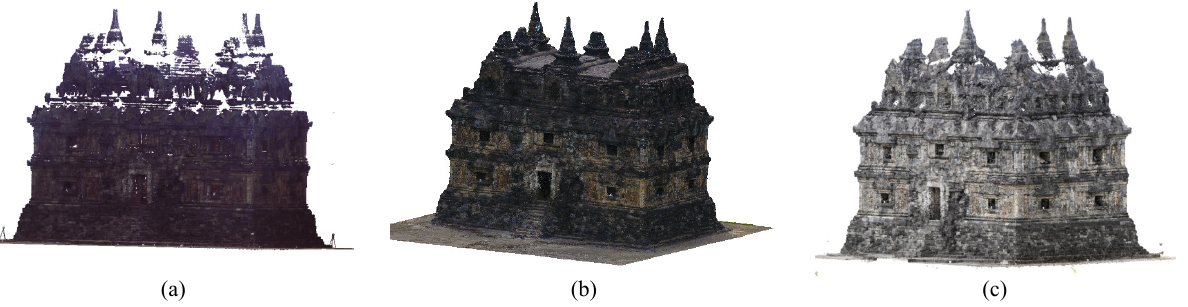
Figure 7. Dense point cloud from each of the data source: (a) TLS, (b) drone, and (c) terrestrial photogrammetry.